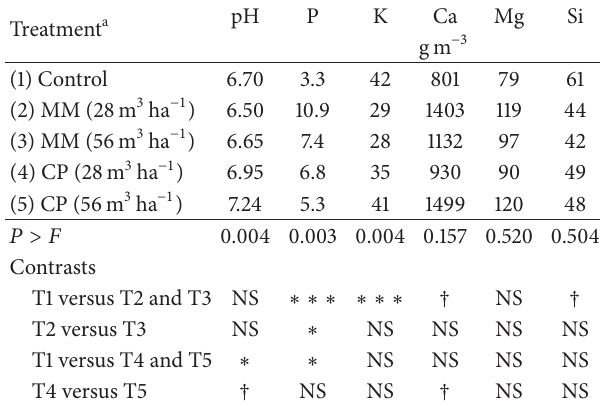
Table 10: Predicted least squares means, 𝑃 > 𝐹 , and significant contrasts for pH and soil-extractable nutrients (in row, 0–15 cm depth) after the plant cane crop at Site